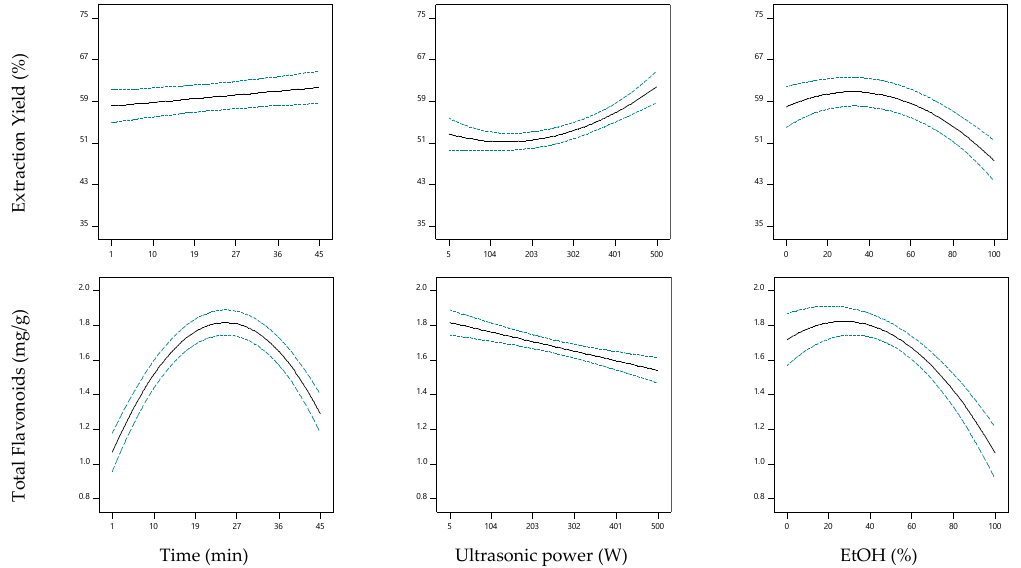
Figure 2. Response surface graphs for the combined effects of the independent variables on the total content of flavonoids ( Y 6 ) and extraction yield ( Y 1 ) obtained from kiwi peel. In each graph, the excluded variable was fixed at its optimal value.